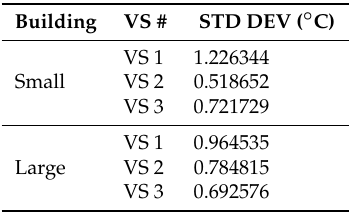
Table 3. Standard deviation results of the deployed virtual